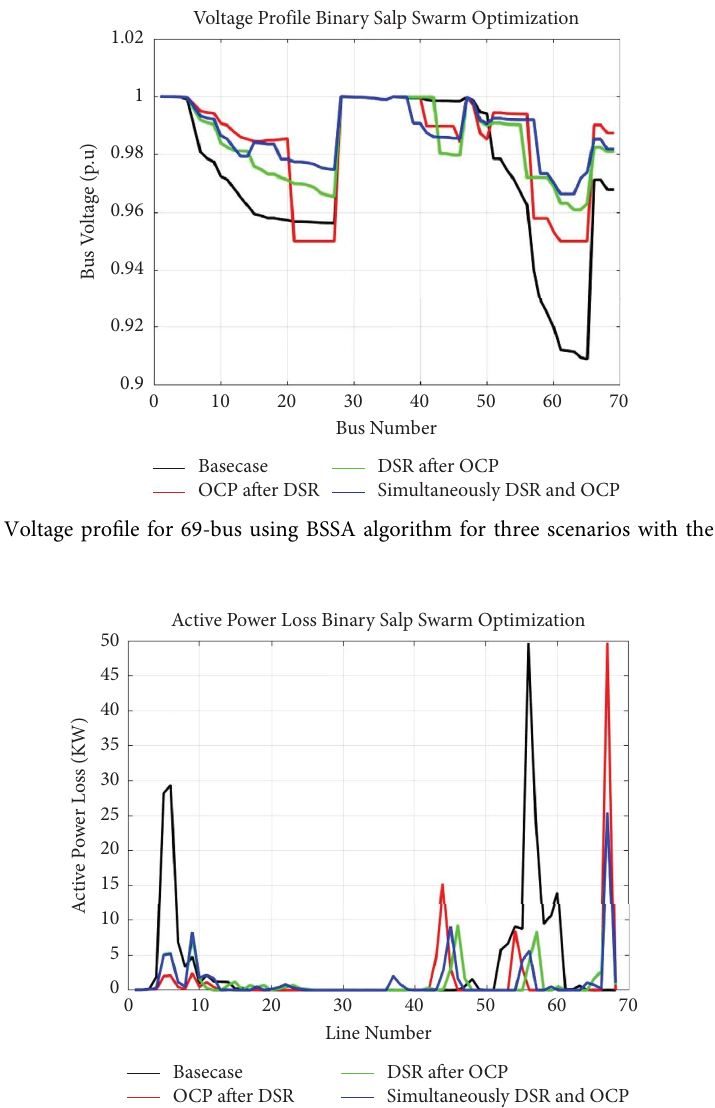
Figure 18: Active losses curve for 69-bus with using the BSSA algorithm for three scenarios with the base case.